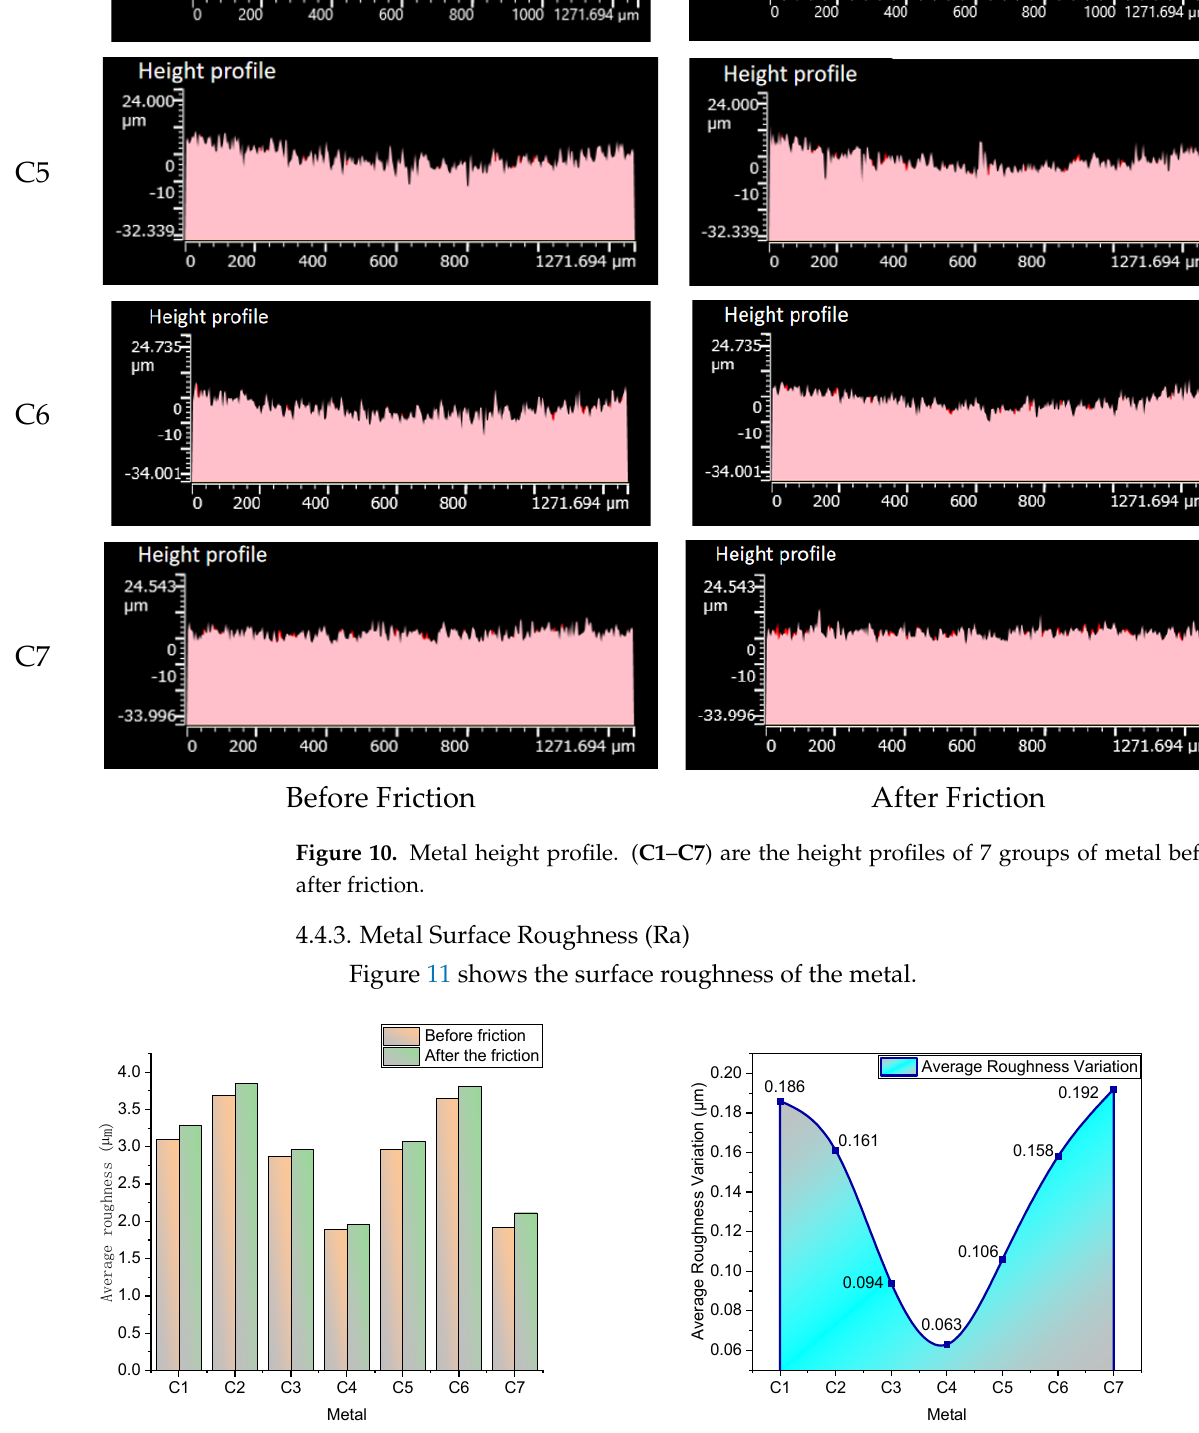
Figure 11. Surface roughness (Ra). The left picture shows the roughness before and after friction, and the right picture shows the roughness